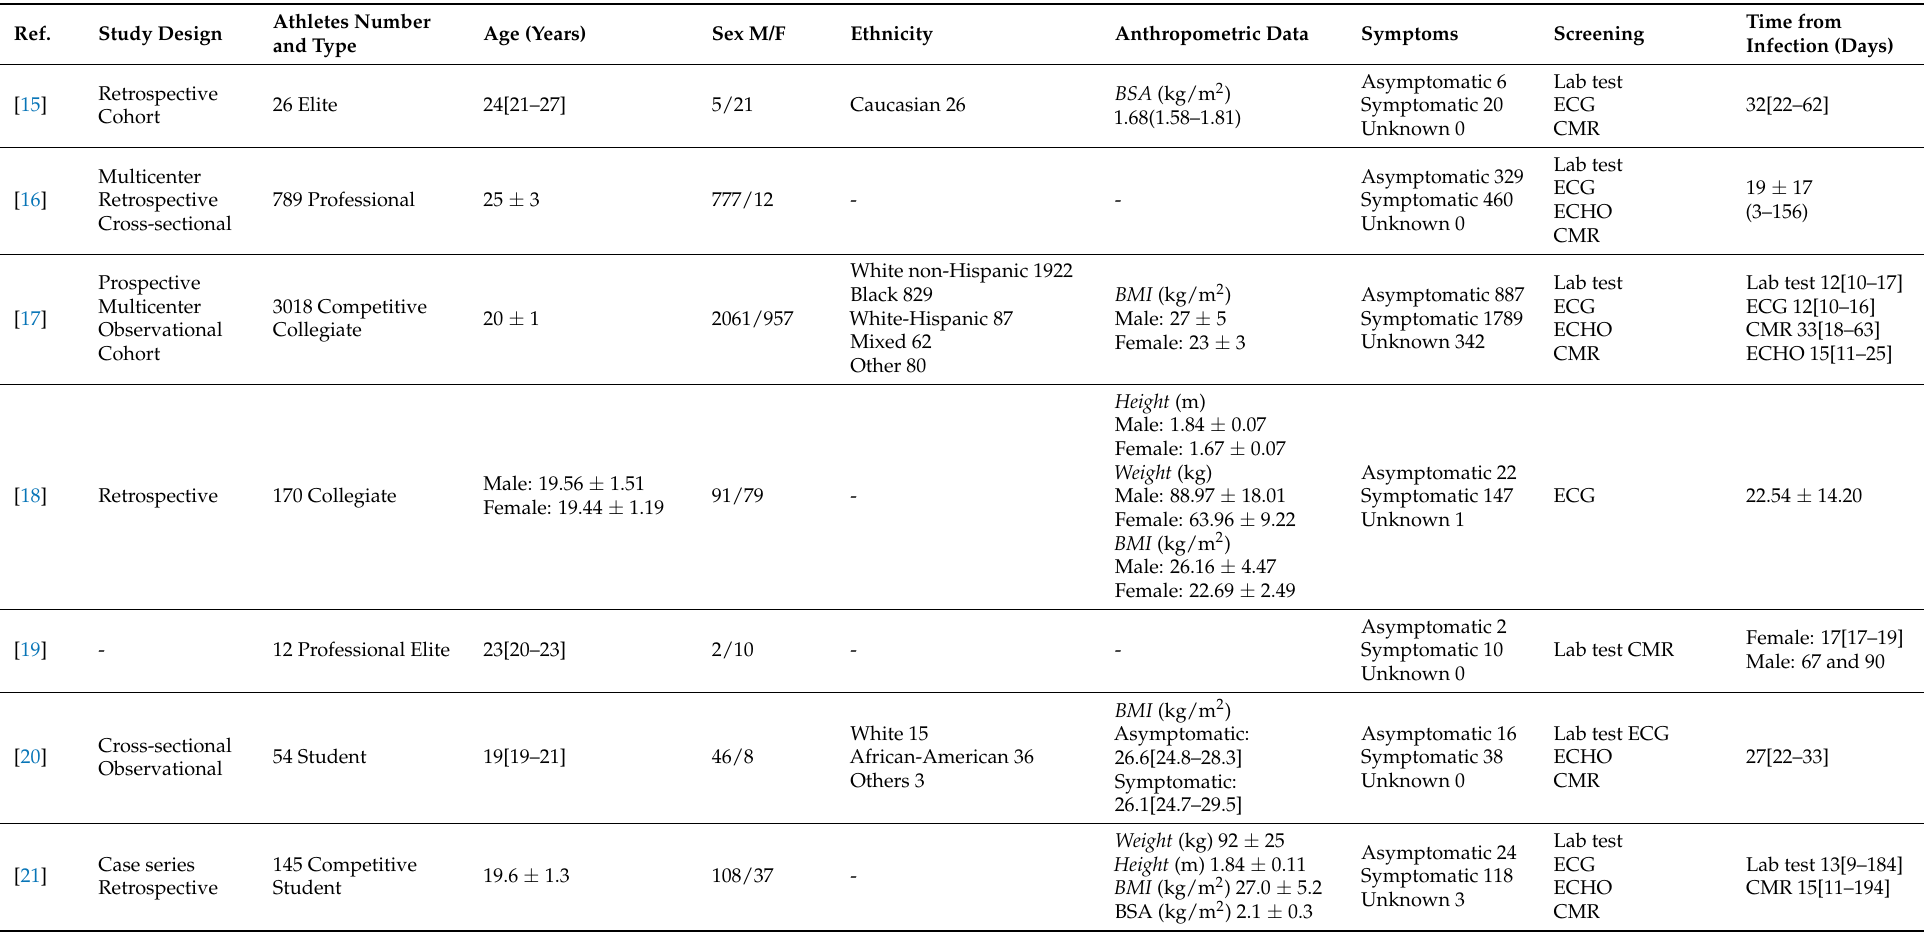
Table 1. Descriptive summary of the analyzed studies. Continuous features (age, anthropometric data, time from infection) are reported in terms of mean ± standard deviation if normally distributed or as median and [interquartile range] or (range) if not normally distributed, as reported in the original studies. Categorical variables (sex and ethnicity) are reported as counts, ratio and/or percentage, as reported in the original studies.